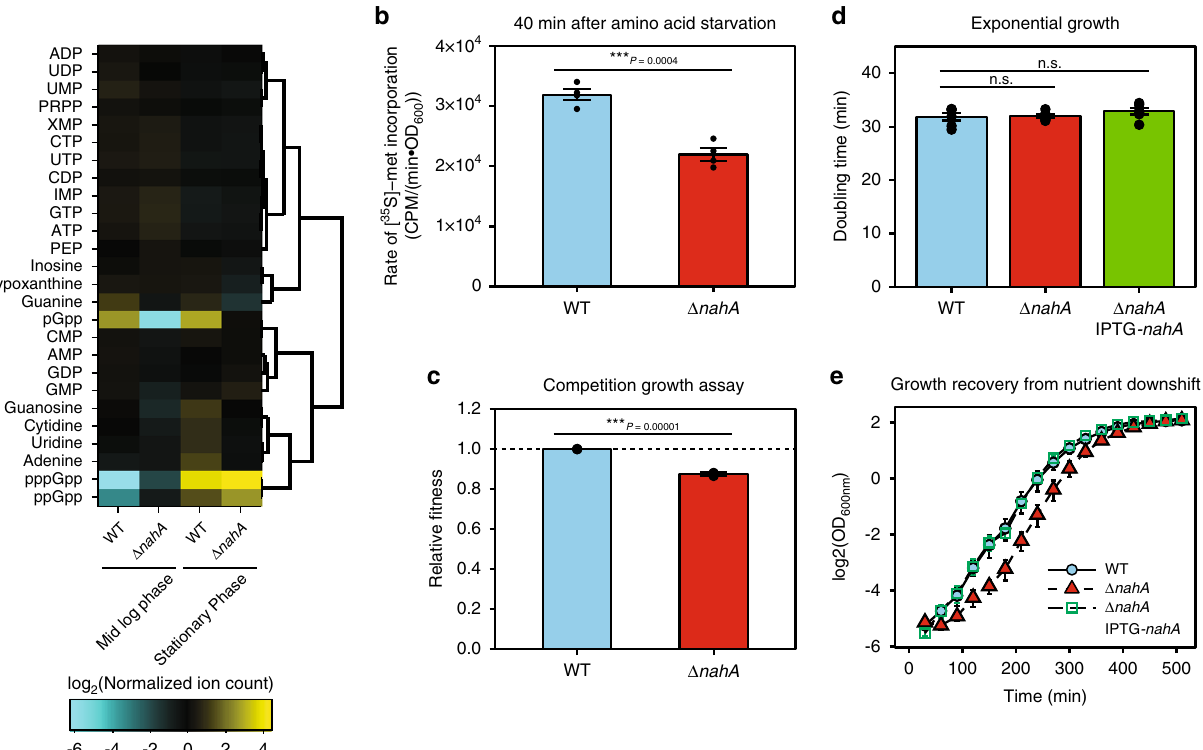
Fig. 4 The effect of NahA on purine nucleotides, translation, fi tness, and growth recovery of B. subtilis cells. a Hierarchical clustering of selected metabolites in exponential growth and stationary phase wild type and Δ nahA cells. Metabolites were measured by LC-MS. Normalized ion count is ion count per OD 600nm per unit volume of the culture. b Protein translation rate of wild type and Δ nahA cells 40 min after amino acid starvation. Translation rate was measured by a 5-min pulse of [ 35 S]-methionine incorporation into TCA-precipitable fraction. Error bars represent standard errors of the mean from three replicates. c Relative fi tness of Δ nahA and wild type strains obtained from a 7-day serial dilution competition assay. Error bar represents standard deviation from three repeats. d Doubling times of Δ nahA and wild-type cells in log phase. A two-tailed two-sample equal-variance Student ’ s t test was performed between samples indicated by asterisks. Asterisk indicates statistical signi fi cance of difference (* P ≤ 0.05, *** P ≤ 0.001, n.s. P > 0.05). e Growth recovery from transient nutrient downshift. Log phase cultures of wild type, Δ nahA and nahA complementation ( Δ nahA IPTG- nahA) strains in rich media with 20 amino acids were fi rstly downshifted in minimum media without amino acids for 10 min, and then diluted in rich media for outgrowth. Result of growth recovery from similar downshift with the presence of guanosine is shown in Figure S6c. Error bars in d , e represent standard errors from six